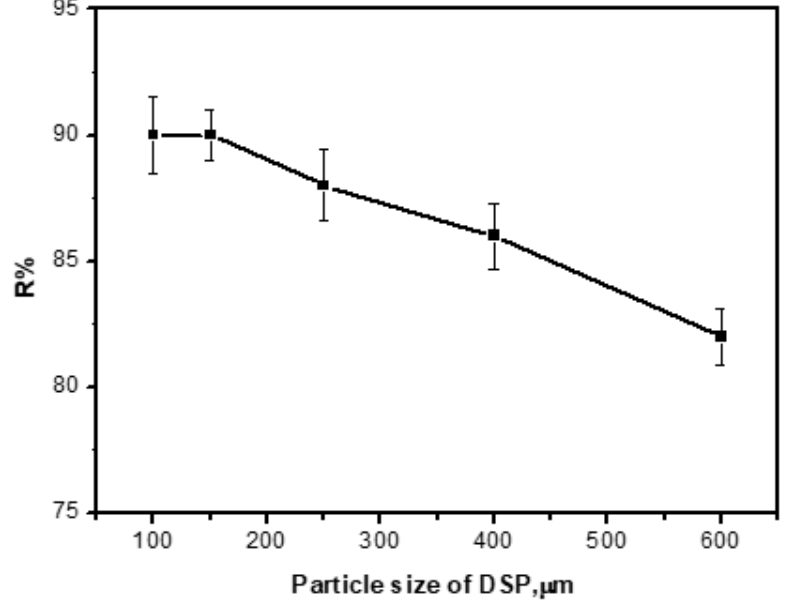
Figure 4. E ff ect of particle size of the DSP on the e ffi ciency of removal of Ni(II) Figure 4. Effect of particle size of the DSP on the efficiency of removal of Ni(II) ions.